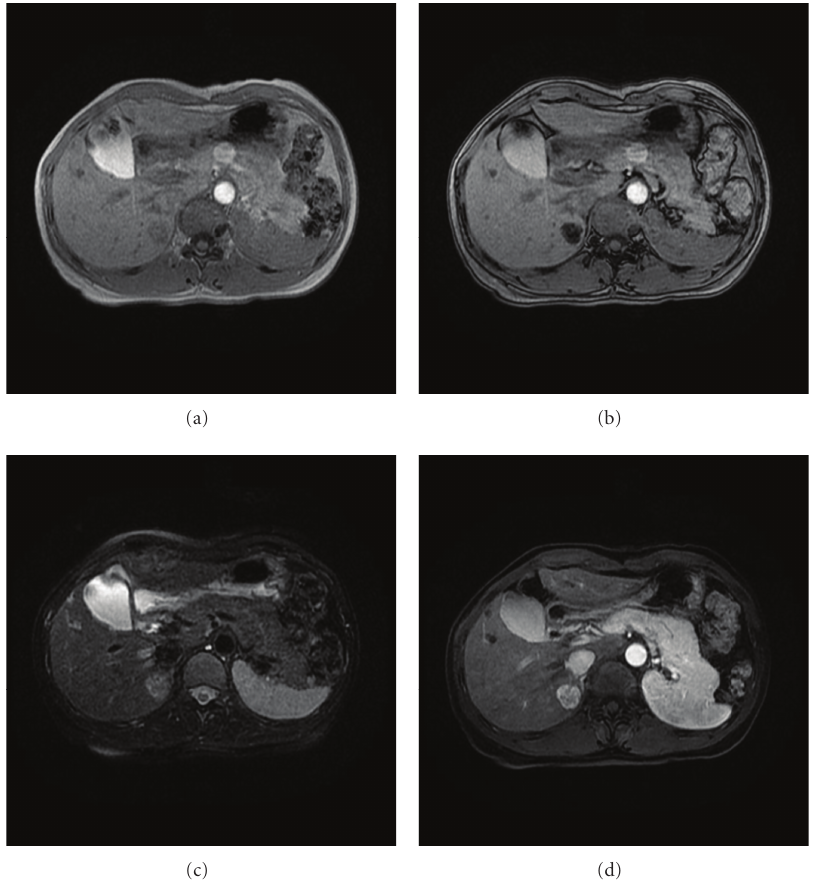
Figure 3: MR findings of the liver mass. On MR T1-weighted in-phase images, the mass shows low signal intensity (a), and on out-of-phase images, the mass shows signal drop and dark signal intensity (b). On MR T2-weighted images, the mass shows high signal intensity (c). The mass demonstrates high signal intensity on arterial phase after contrast injection